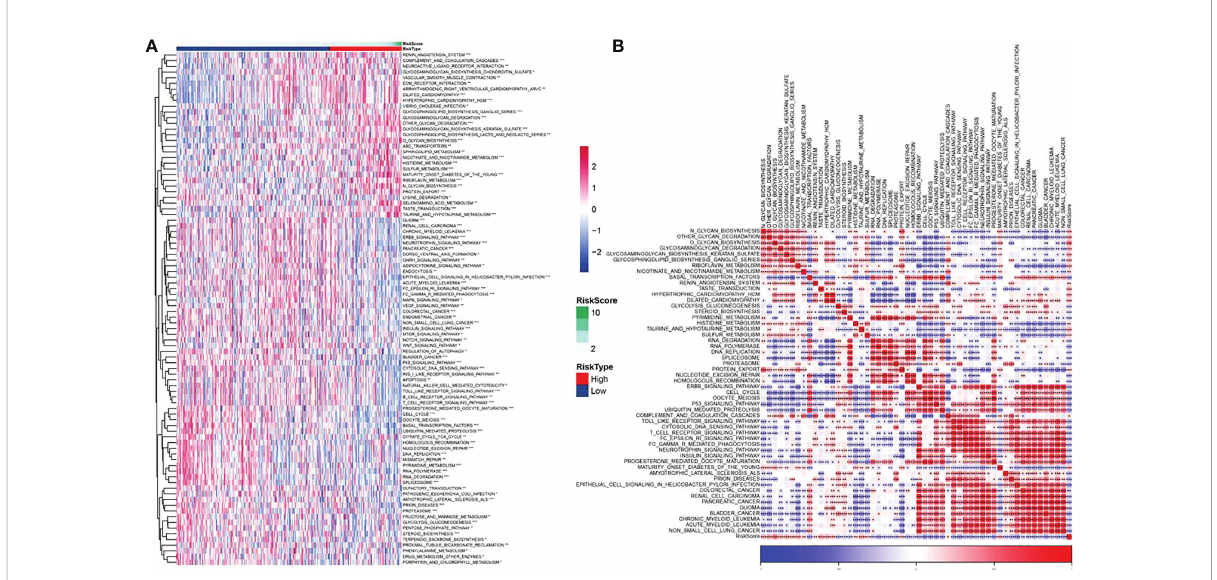
FIGURE 11 Biological pathway for potential regulation of FAMRGs prognosis-related model (A) Heat map in which GSVA analysis of TCGA dataset pathway showed signi fi cant enrichment scores of related pathways in high and low risk groups, and (B) Heat map of correlation analysis of pathways with signi fi cant differences in TCGA data sets and RiskScores